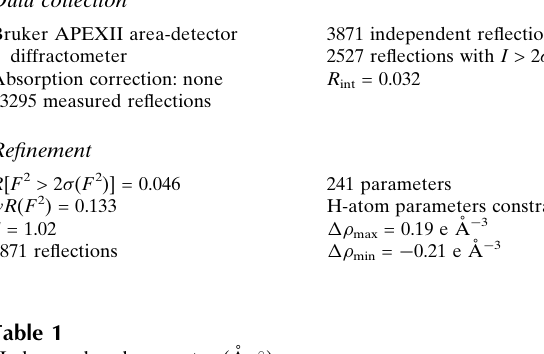
Hydrogen-bond geometry (A˚ , (cid:1)